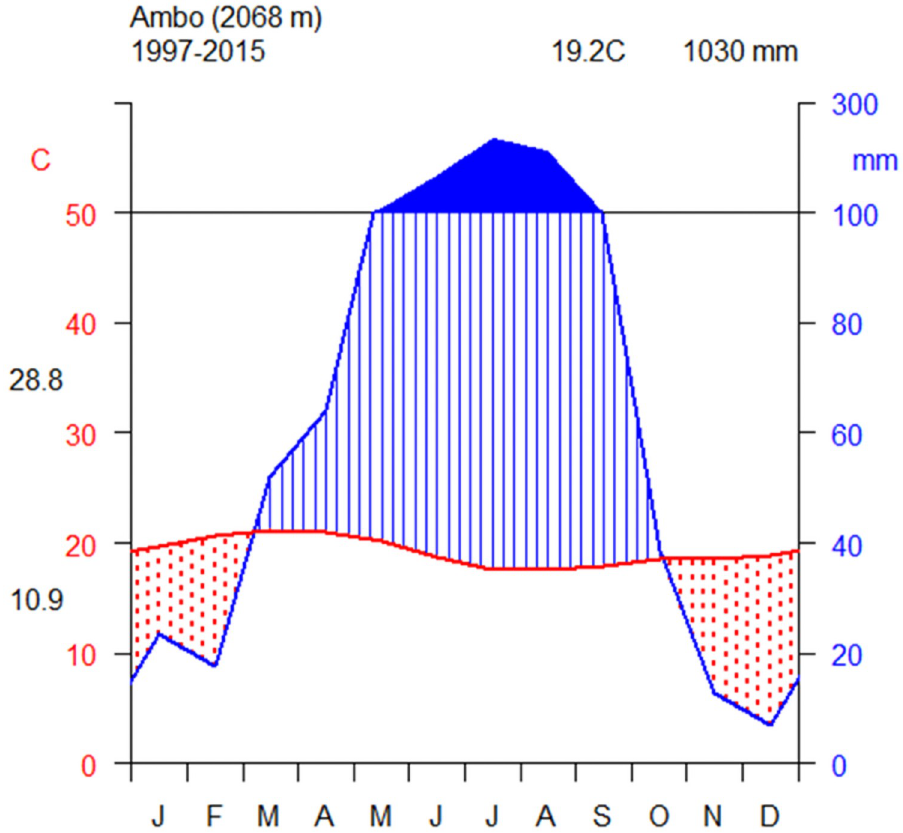
Fig 2. Climadiagram of Ambo weather station near Kibate Forest. The y-axis shows the average annual precipitation (mm) and average annual maximum and minimum temperature (˚C) and elevation (meters above sea level), and the x-axis shows the month of the year beginning from January to